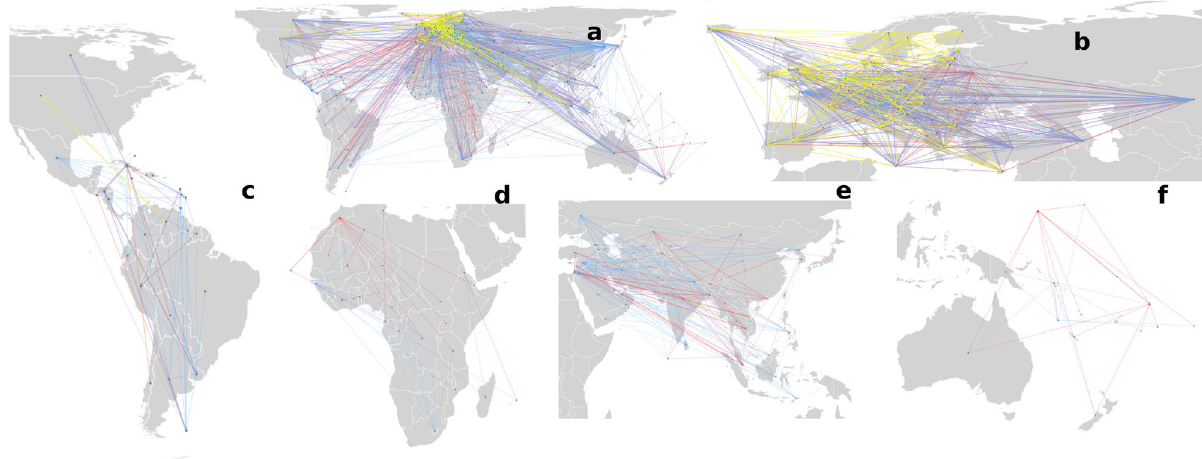
Fig. 1 The world-wide waste web. Superposition of the W4 networks of types I (red edges), type II (blue edges), and type III (yellow edges) of waste, where the nodes represent the countries which traded the corresponding waste in the years 2001 – 2019. The direction of the edges indicates the fl ow from exporter to importer as reported in the BaC database. A view of the global network in ( a ), with zooms for the local networks of Europe in ( b ), the Americas ( c ), Africa ( d ), Asia ( e ), and Oceania ( f ). Map tiles by Bjorn Sandvik, under CC BY-SA 3.0 available at http://thematicmapping.org/downloads/